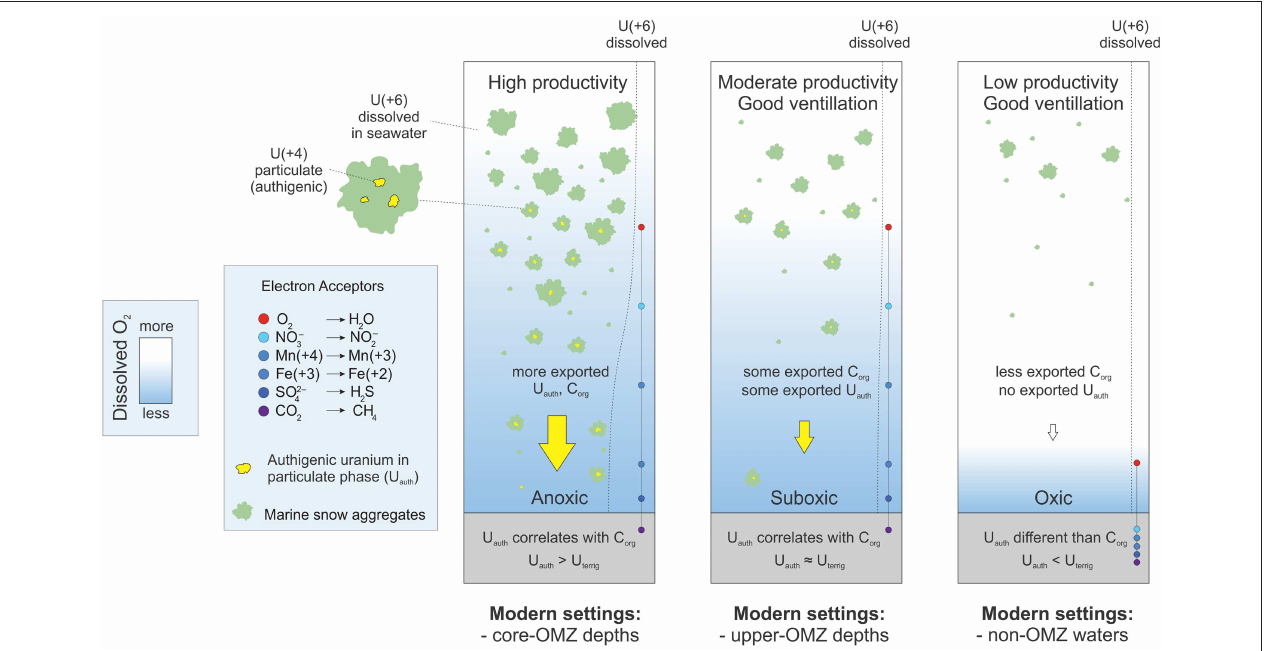
FIGURE 10 | Hypothetic scenarios of uranium biogeochemistry in modern OMZs.